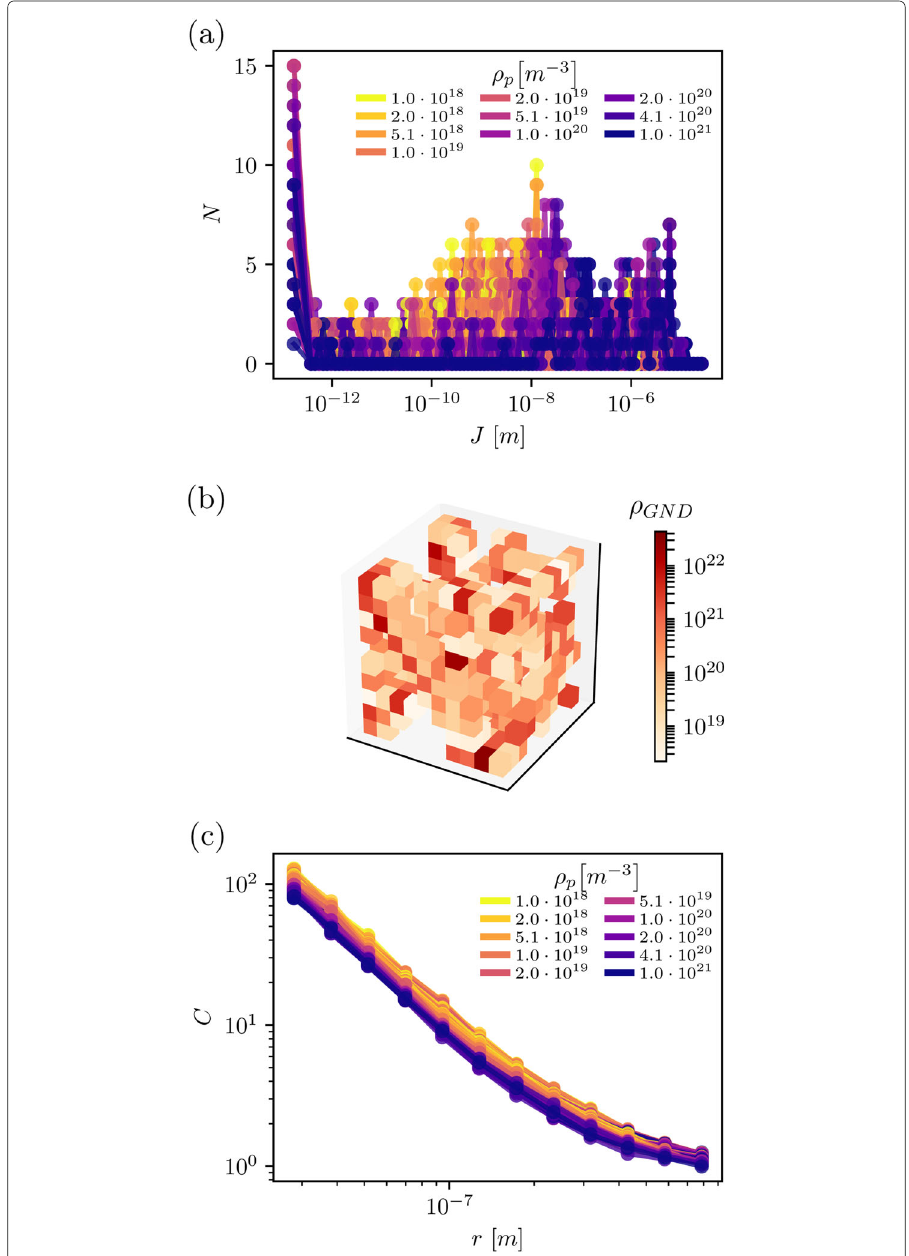
Fig. 3 Different ways to measure the dislocation structure. a Distribution of dislocation junction lengthening J (Eq. 2) in single systems at t = 2.6 · 10 5 GM . The first bin also includes junctions with J = 0. b An example of internal GND density at t = 2.6 · 10 5 GM in a system with ρ p = 10 20 m − 3 . c Dislocation spacing correlation according to Eq. 4 in single systems at t = 5.2 · 10 6